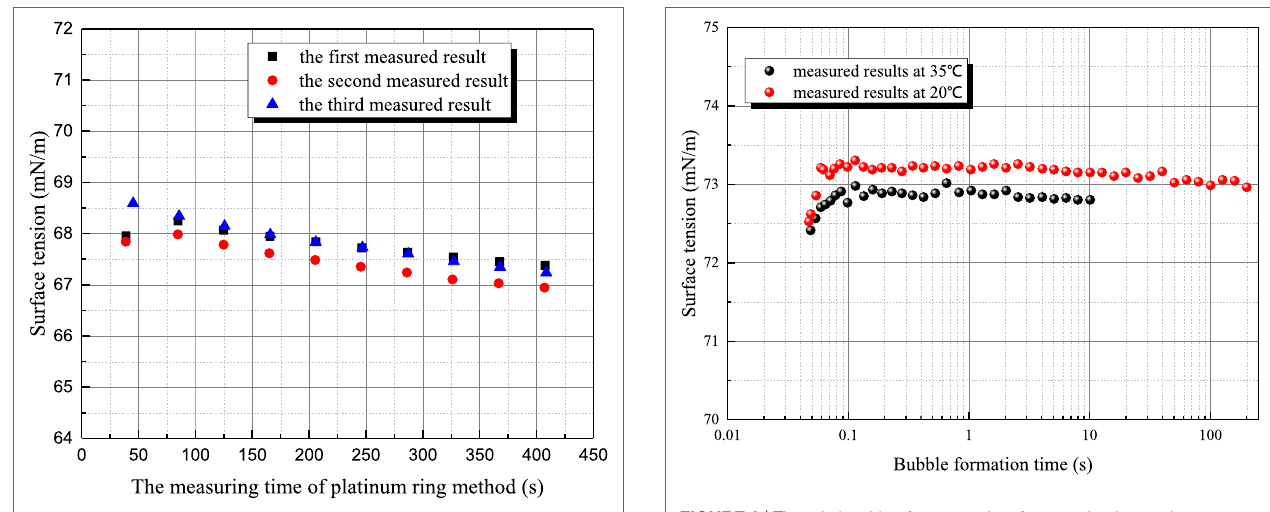
FigUre 4 | The history of measured surface tension of sodium thiosulfate by platinum ring method (sodium thiosulfate concentration is 1 mol/L; solution temperature is